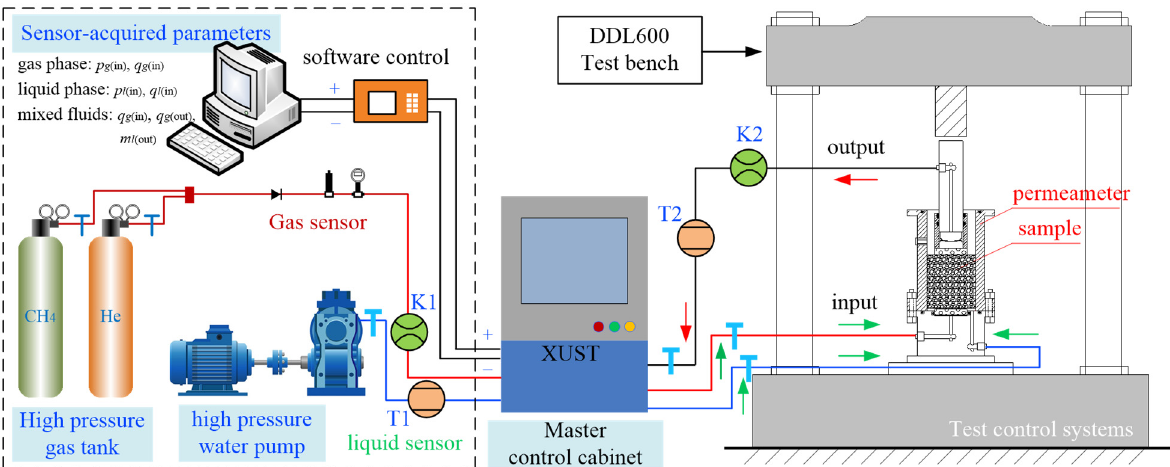
Figure 4. Schematic design for testing water–gas two-phase seepage parameters in fractured coal